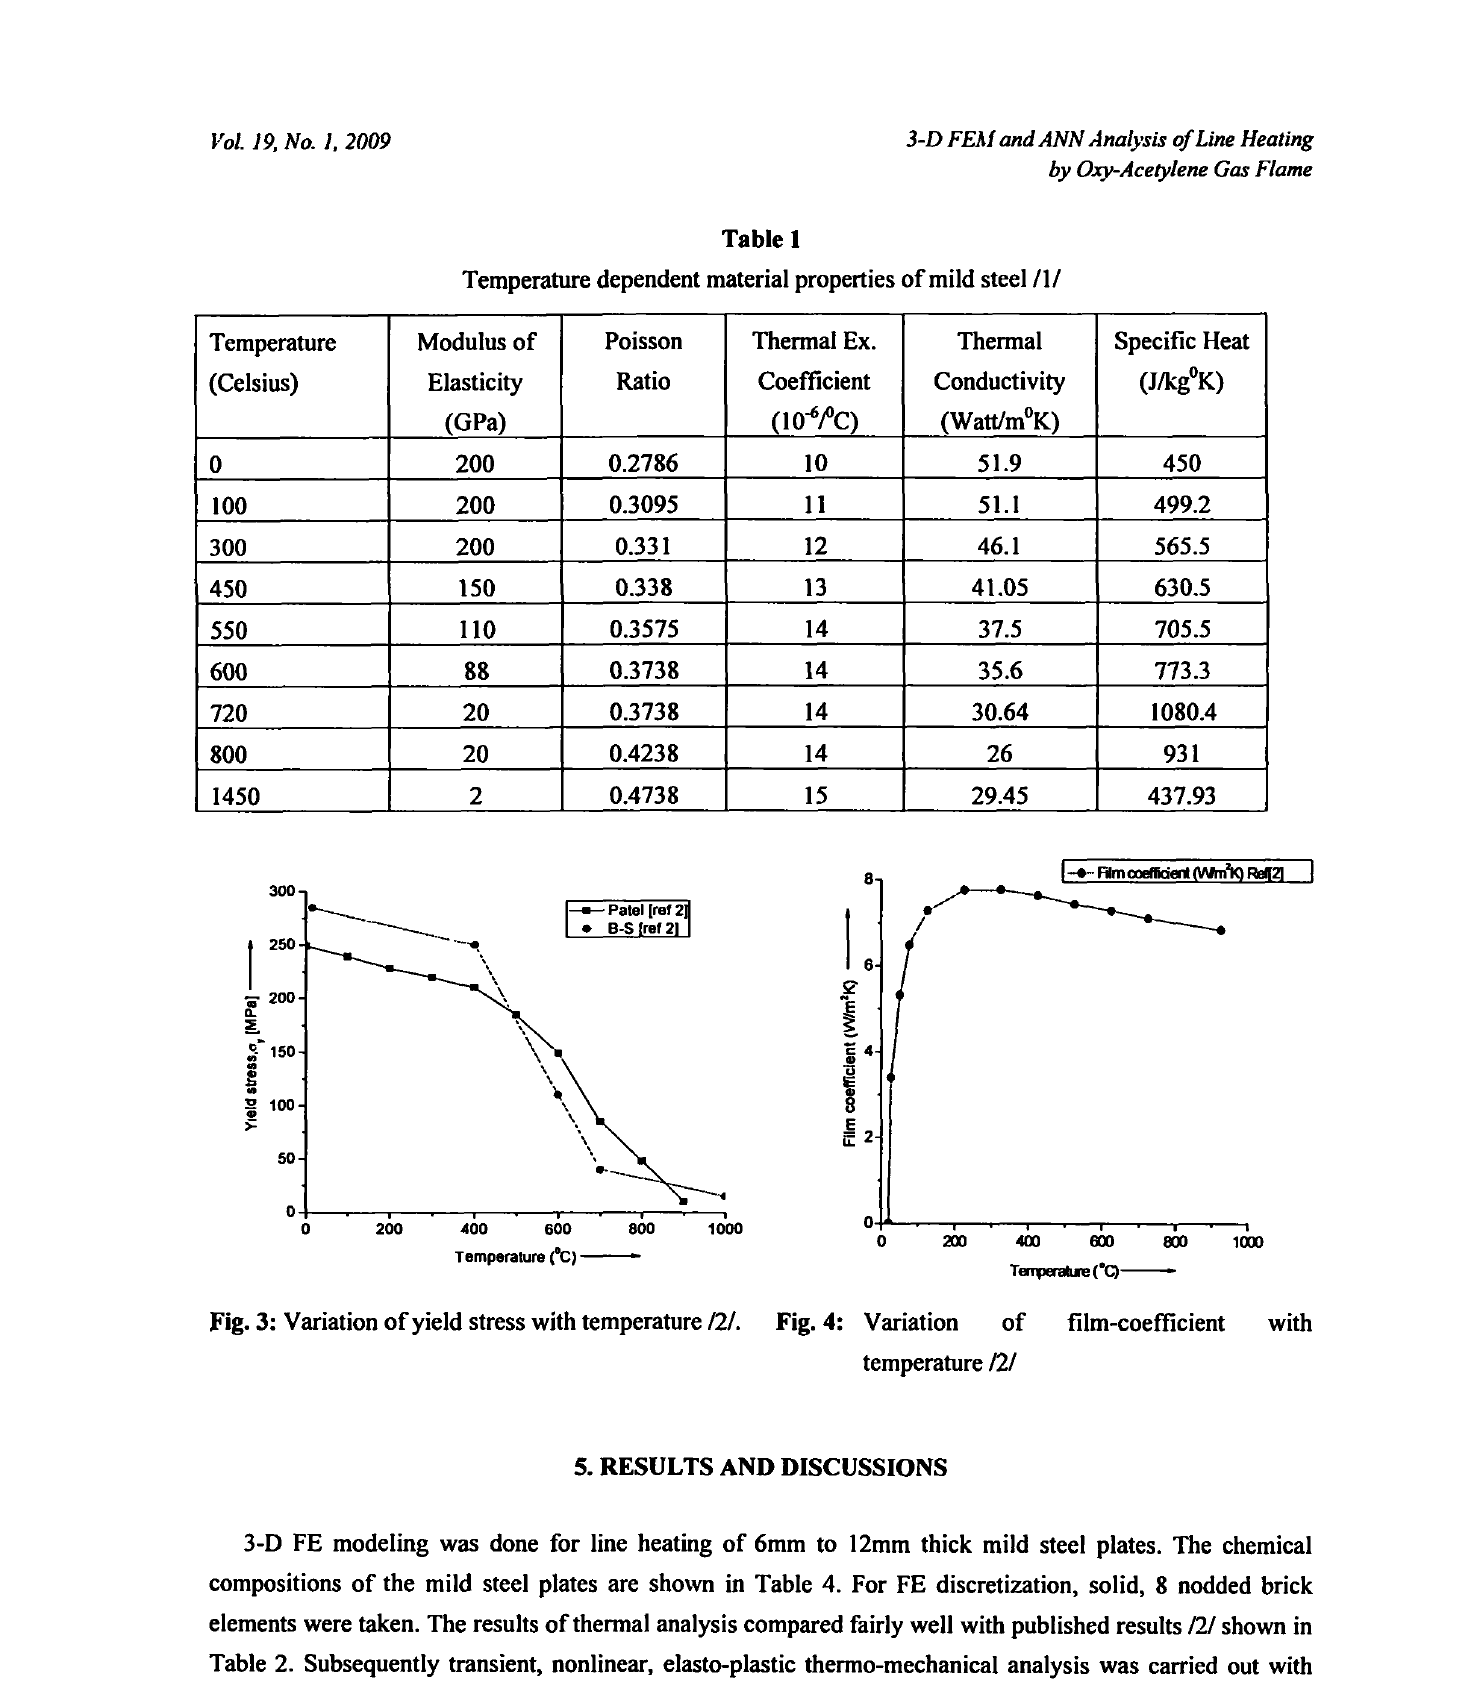
Temperature dependent material properties of mild steel /!/